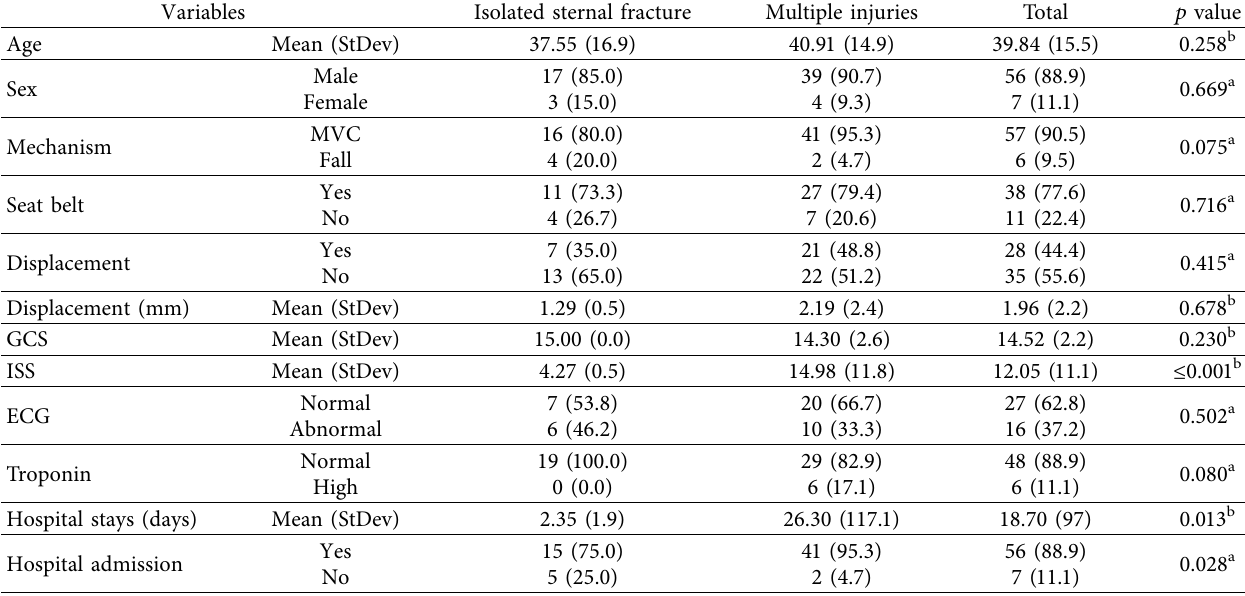
Table 3: Comparison between patients with an isolated sternal fracture and those with other concomitant injuries in terms of diferent variables.